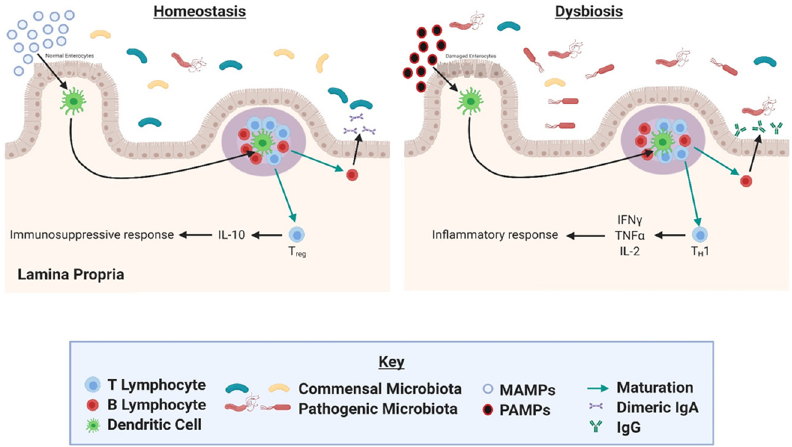
Figure 1. Potential microbiota signaling mechanism in the gut. Dendritic cells in the gut lining sample bacterial antigens. The dendritic cells present the antigens to T cells in the Peyer’s patches (represented by purple circle). Antigen presentation can induce T-cell differentiation, regulating inflammation. Figure was created with BioRender.com.